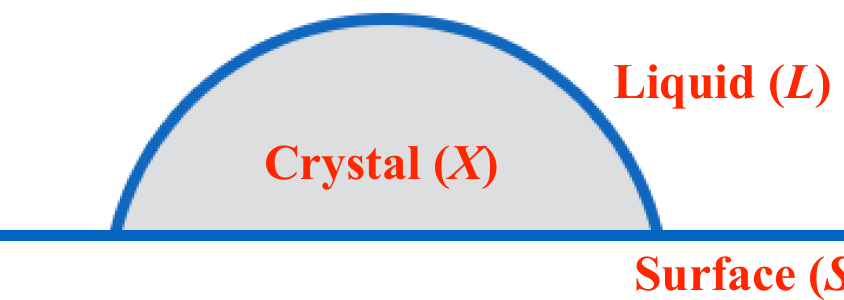
Figure 4. Schematics showing different regions surrounding a crystal grain nucleated from the sur- face.